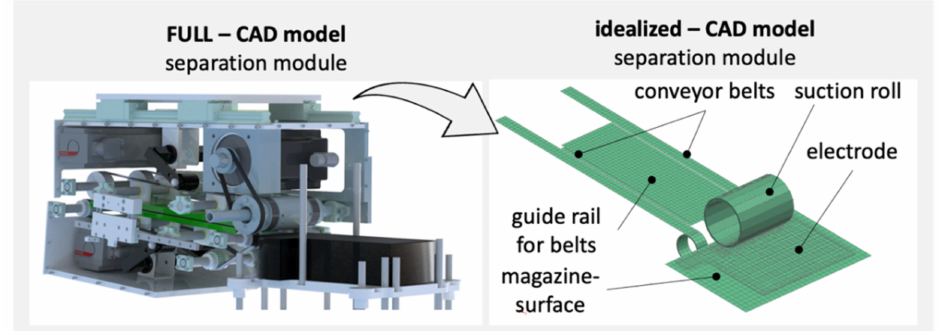
Figure 5. Idealized model of the separation module representing the essential components that are necessary for the simulation of the subprocess.